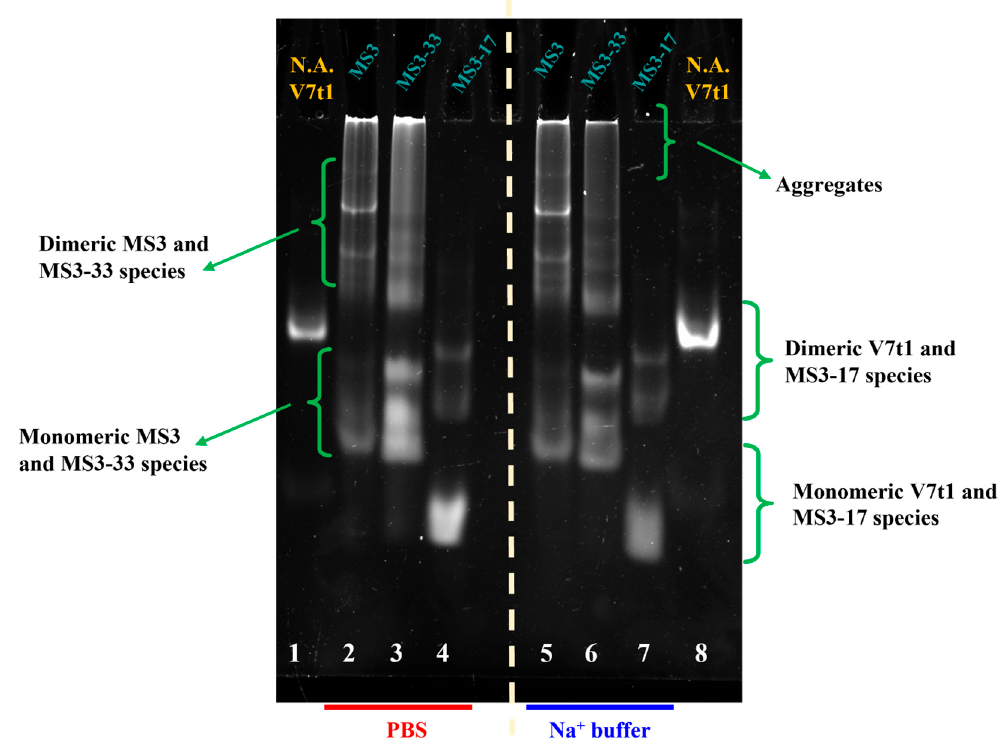
Figure 5. Representative 10% polyacrylamide gel electrophoresis under native conditions of MS3, MS3-33, and MS3-17 samples at 3 μ M concentration in the selected PBS (lanes 2–4) and Na + buffer (lanes 5–7) solutions, run at constant 80 V at r.t. for 75 min in TBE 1× buffer. The not-annealed (N.A.) V7t1 aptamer dissolved in HEPES/Na + buffer (25 mM HEPES, 150 mM NaCl, pH = 7.4) at 4 μ M concentration was used as a control oligonucleotide (lanes 1 and 8). Lane 1: V7t1; lane 2: MS3; lane 3: MS3-33; lane 4: MS3-17; lane 5: MS3; lane 6: MS3-33; lane 7: MS3-17; lane 8: V7t1.